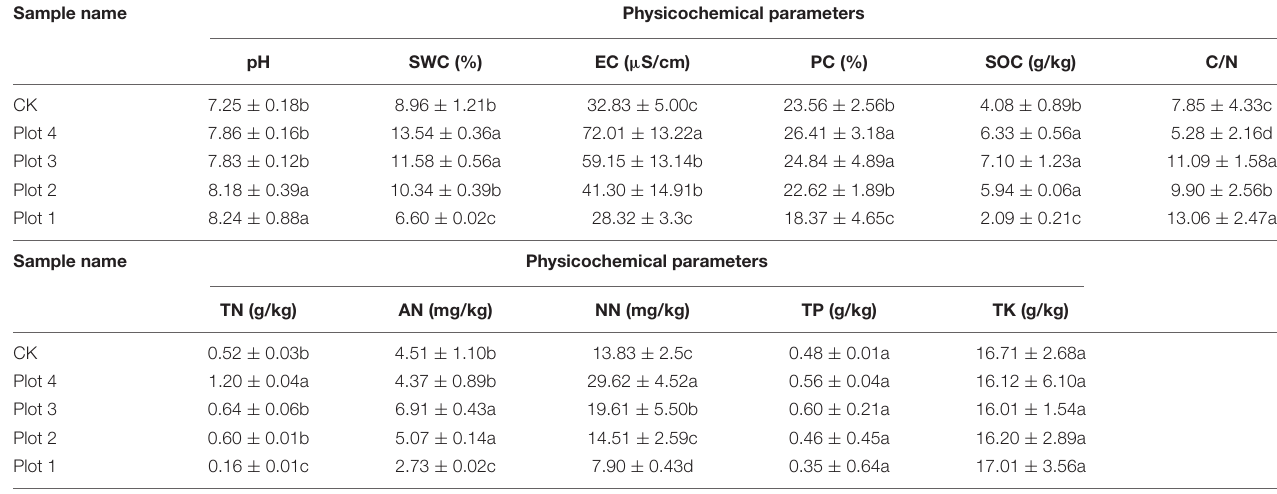
TABLE 1 | Physicochemical properties of the soil in different reclamation